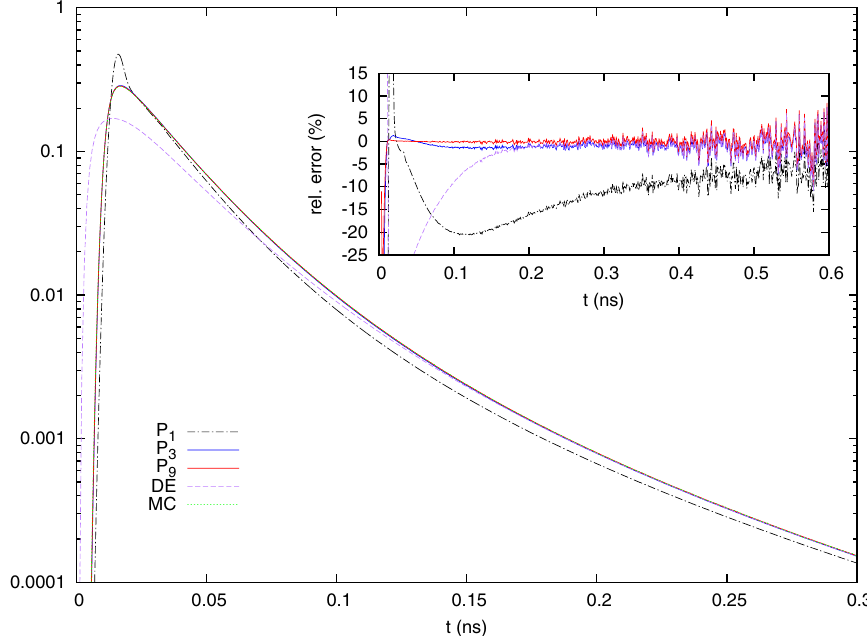
Figure 2. Time-resolved reflectance from the two-layered scattering medium with upper layer thickness of l = 2 mm and a refractive index of n m = 1.4 due to an infinitely short, perpendicularly incident light pulse with a spatial Gaussian beam profile. The beam radius is ρ w = 0.5 mm and the source-detector separation ρ = 2 mm. The refractive index of the surrounding medium is n 0 = 1.0. Already for N ≥ 3, a good agreement between the Monte Carlo simulation and the P N solution is observed. For the Monte Carlo simulation 10 11 photons were